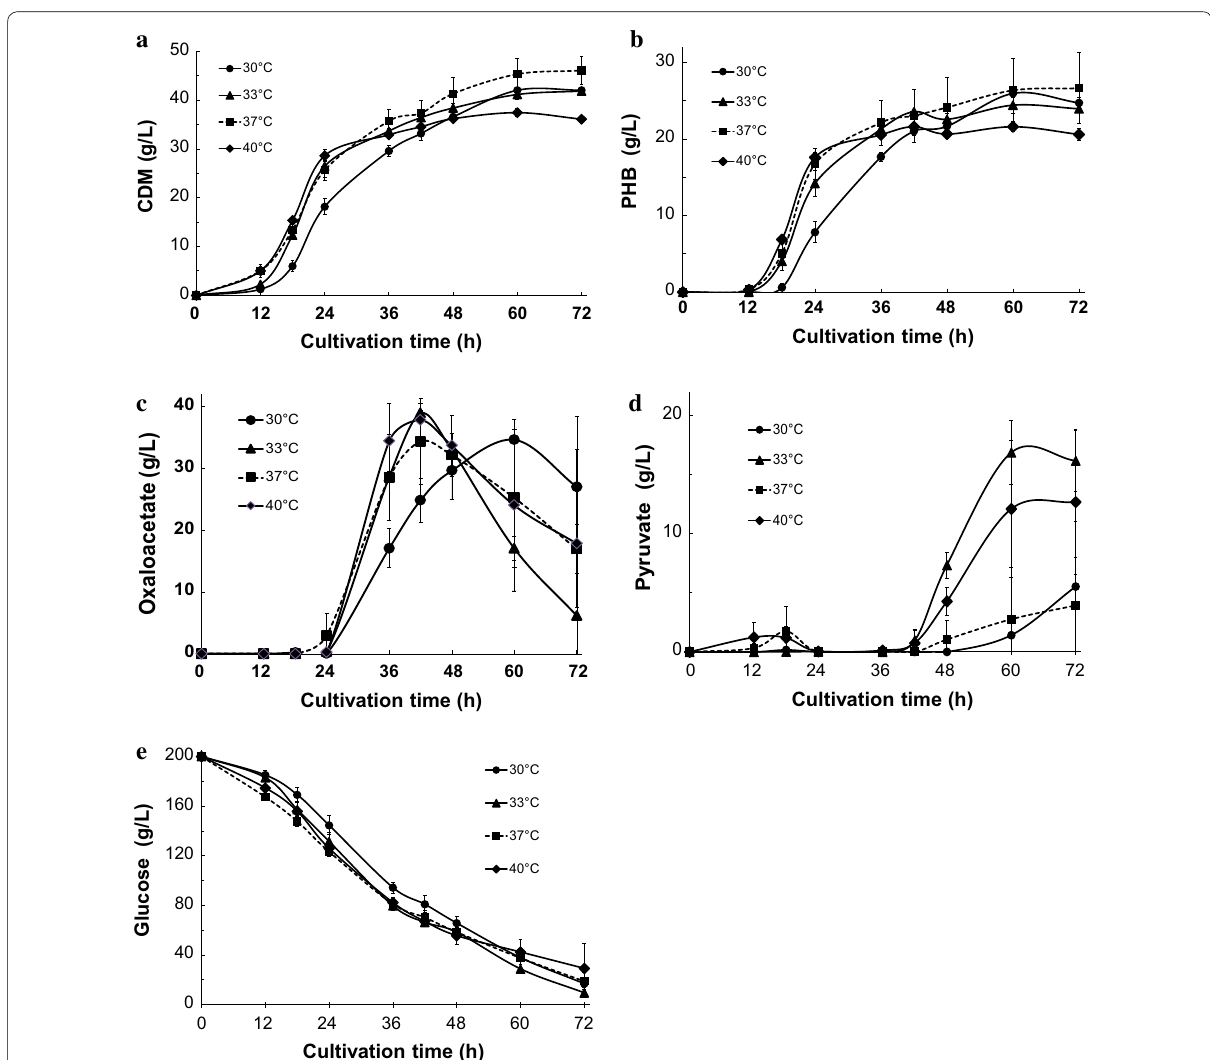
Fig. 3 Oxaloacetate, pyruvate, and bioplastic poly-( R )-3-hydroxybutyric acid production by Halomonas sp. KM-1 under varying culture tempera- tures. The medium was composed of modified SOT medium. KM-1 cells were cultured under aerobic conditions (agitation speed: 200 rpm) at 30 °C (circles), 33 °C (triangles), 37 °C (squares; dotted line in Fig. 2), or 40 °C (diamonds), with addition of extra 0.8 M NaCl at 24 h. a Cell dry mass (CDM), b intracellular bioplastic poly-( R )-3-hydroxybutyric acid (PHB), c oxaloacetate, d pyruvate in the medium, and e glucose in the medium were analyzed. The data shown represent the mean SD of five independent ±